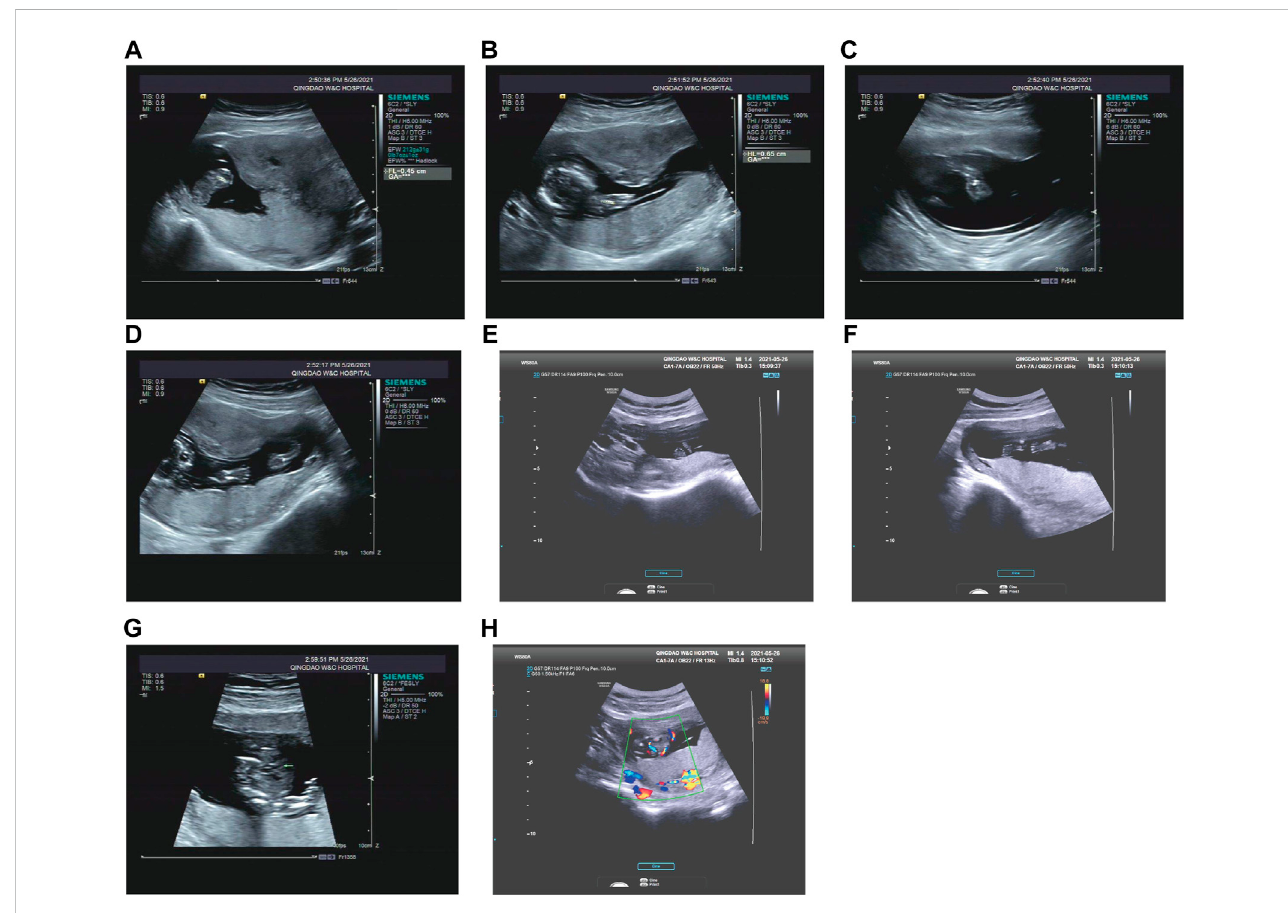
FIGURE 3 Antenatalultrasoundoffoetus3 (A) Thefemurlengthwas0.45 cm. (B) Thehumeruslengthwas0.65 cm. (C) Theulnaandradiuswerenotclearlyshown. (D) Thetibio fi bulawasnotclearlyvisualized. (E) Polydactylyofbothfeet. (F) Postureabnormalitiesofbothfeet. (G) Abnormalstructureoffour-chamberheart. (H) single umbilical artery.